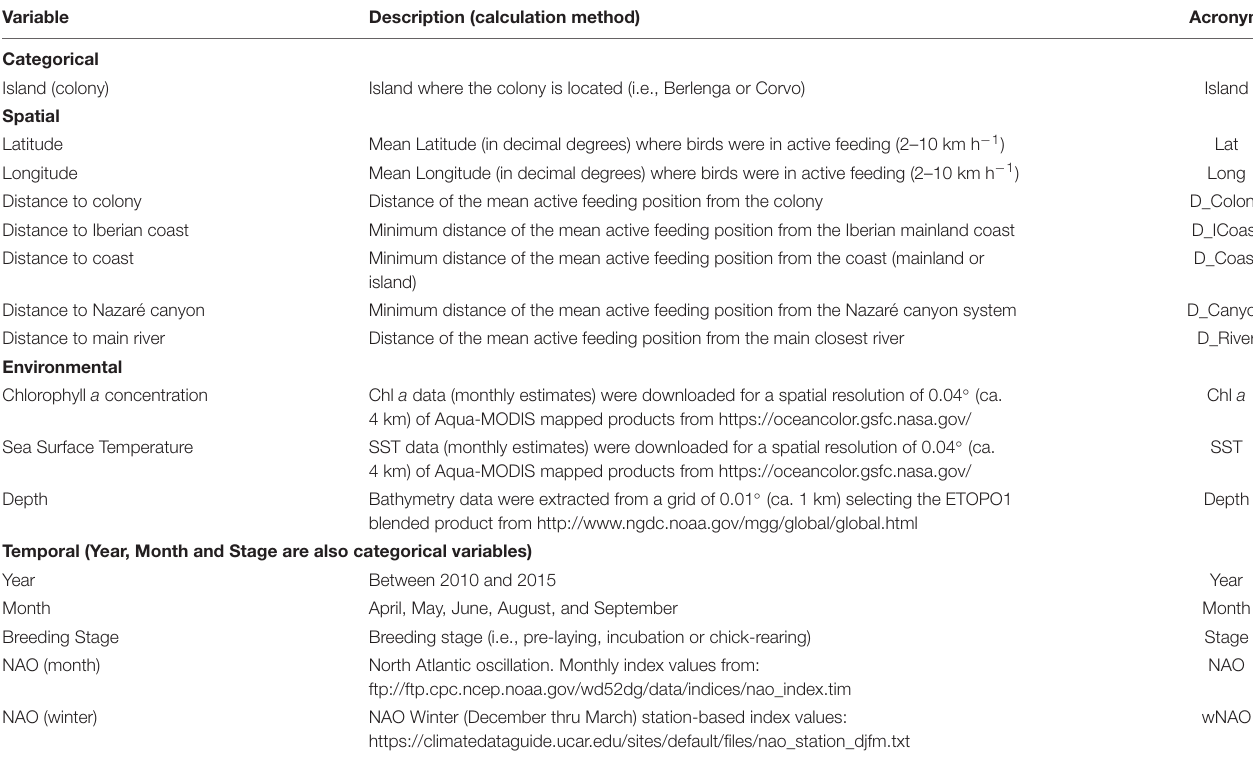
TABLE 1 | Predictor variables used for modeling spatio-temporal dynamics in stable isotope values ( δ 13 C and δ 15 N) measured in the plasma of tracked Cory’s shearwaters ( Calonectris borealis ) in the North Atlantic.